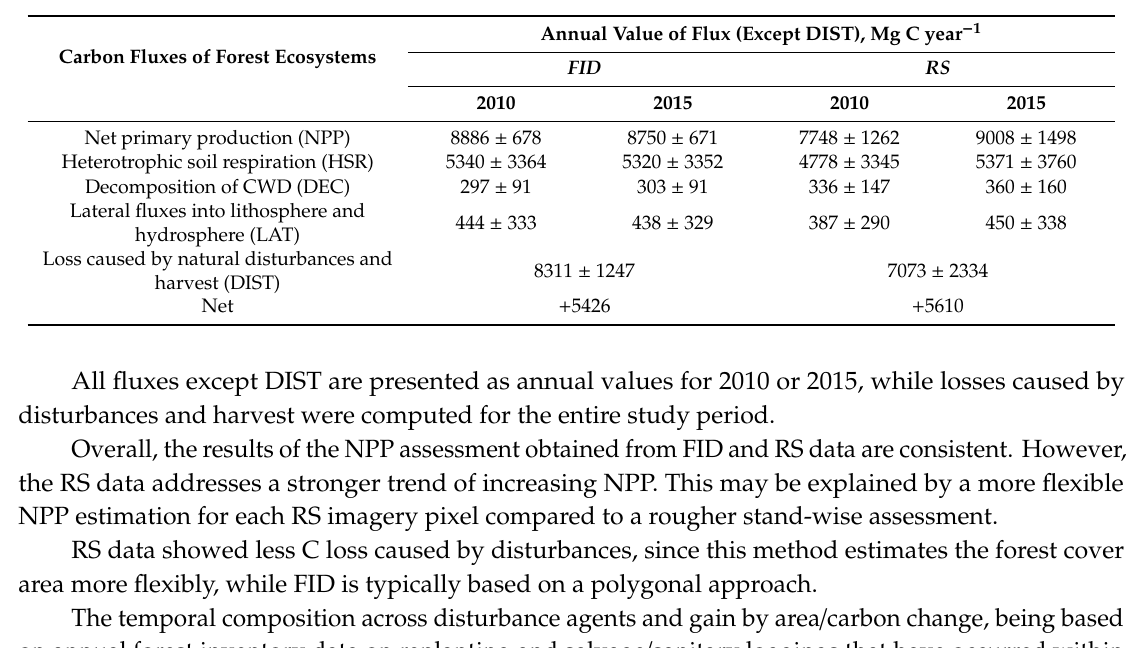
Table 12. Flux-based C changes,